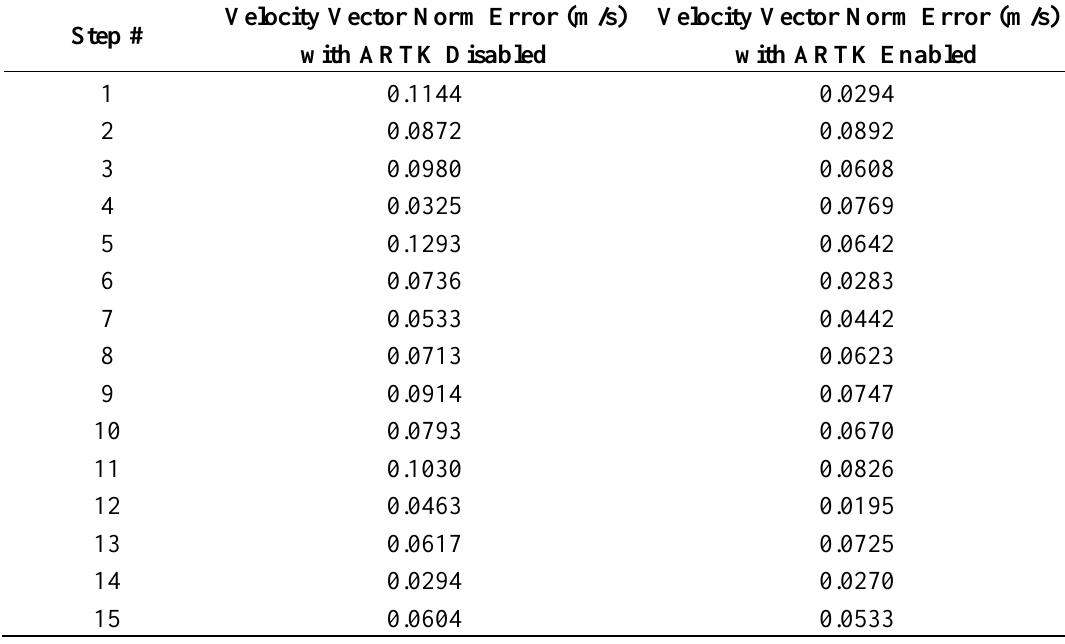
Table 1. IMU velocity vector norm error just before ZUPT triggering occurred, for each step of the slow walking experiment.